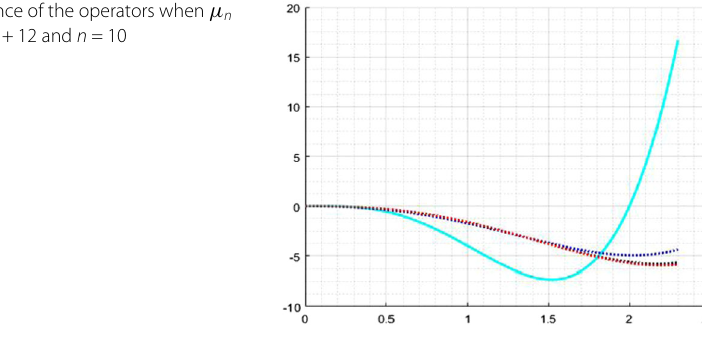
Figure 4 Convergence of the operators when μ n √ = n + n + 1, ν n = n + 12 and n =